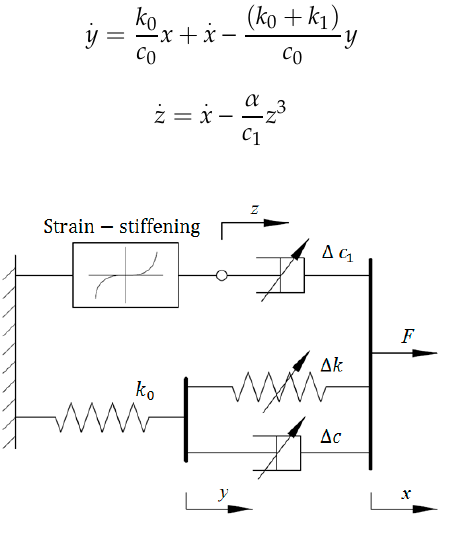
Figure 8. Strain stiffening model.